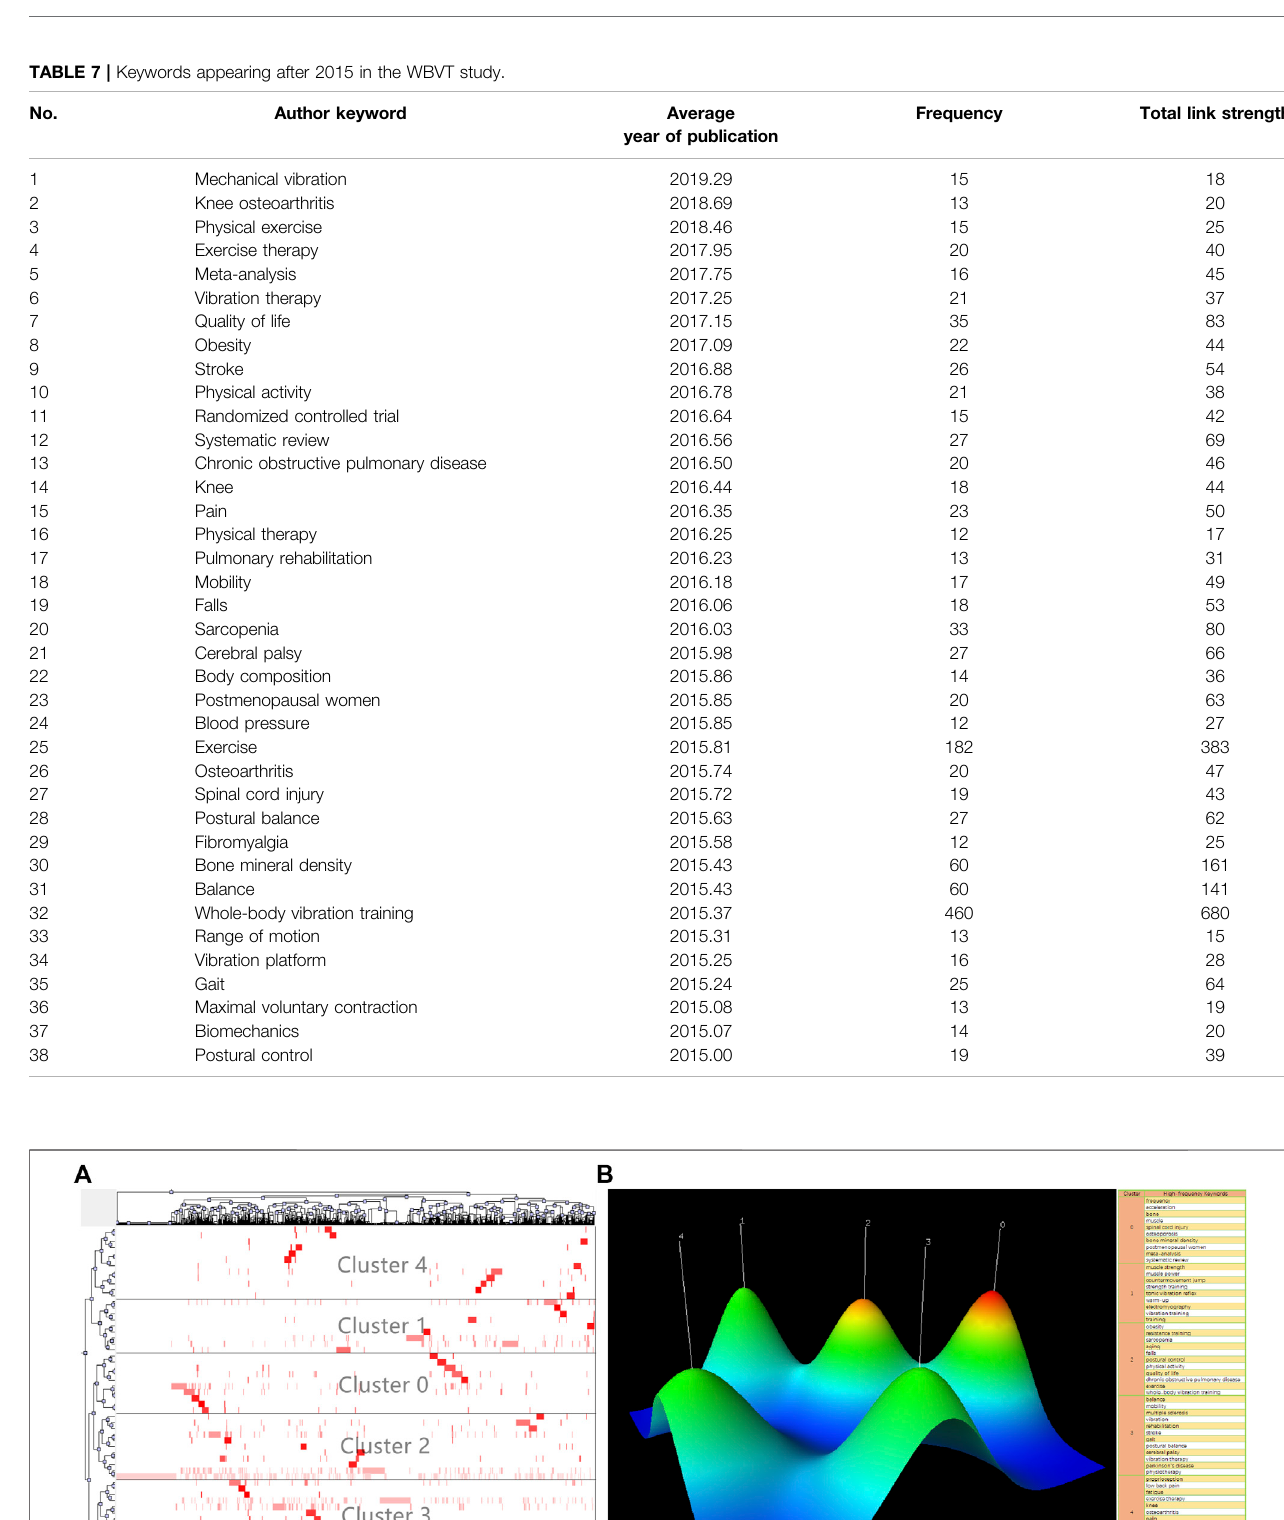
Frontiers in Bioengineering and Biotechnology |